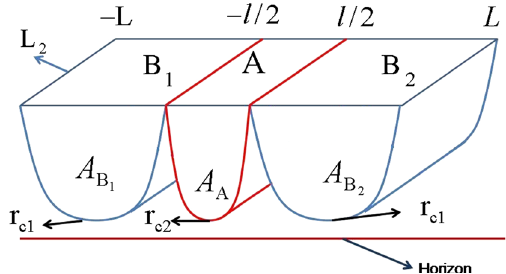
Fig. 3 Schematic of static minimal surfaces anchored on the subsys- tems A , B 1 and B 2 in the high temperature